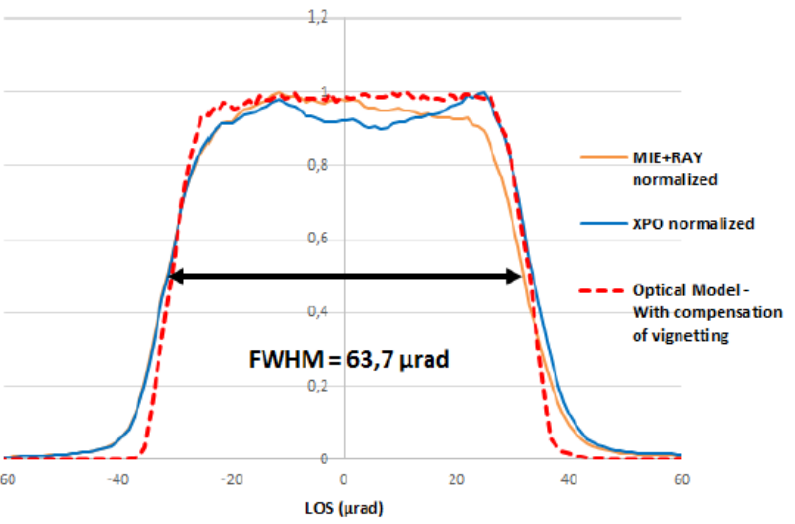
Figure 12. Example of instrument field-of-view characterisation measurements performed during TVAC; channels’ normalised responses vs OGSE Line-of-Sight scan. TVAC; channels’ normalised responses vs. OGSE Line-of-Sight